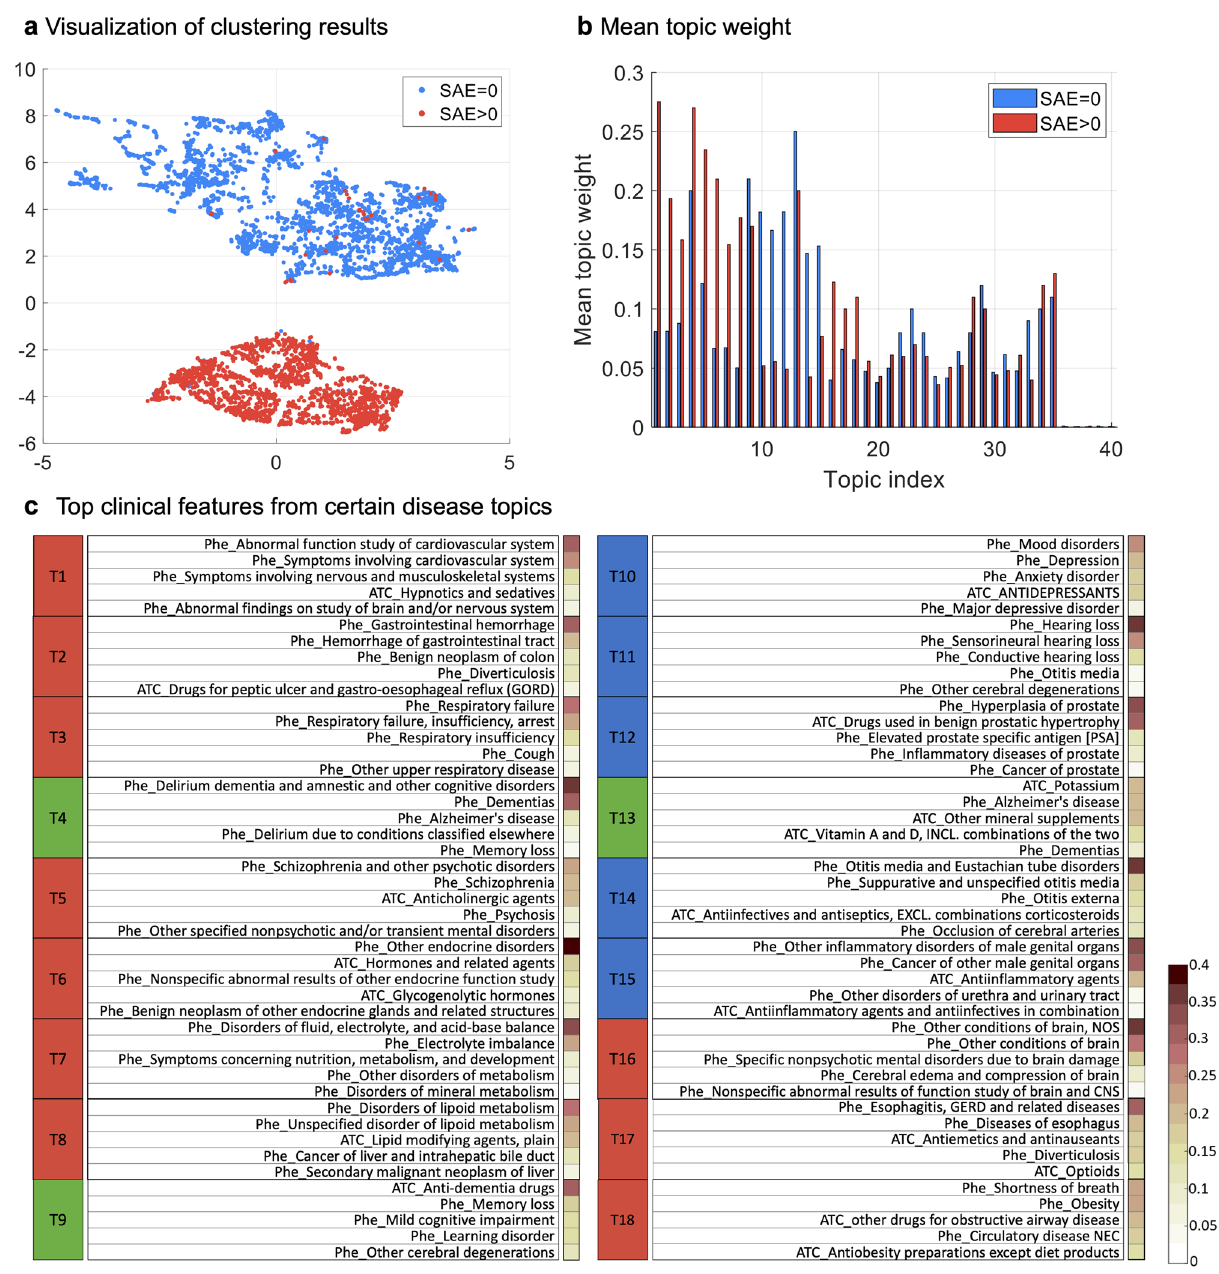
Figure 4. Clustering results of the AD target population. ( a ) Visualization of clustering results. ( b ) Mean topic weight (MTW) of all topics on two groups, where the x-axis is the topic index and the y-axis is the MTW of each topic on two subgroups. ( c ) Top features from certain disease topics. The right sidebar of each topic shows the percentage of patients with the corresponding feature in that